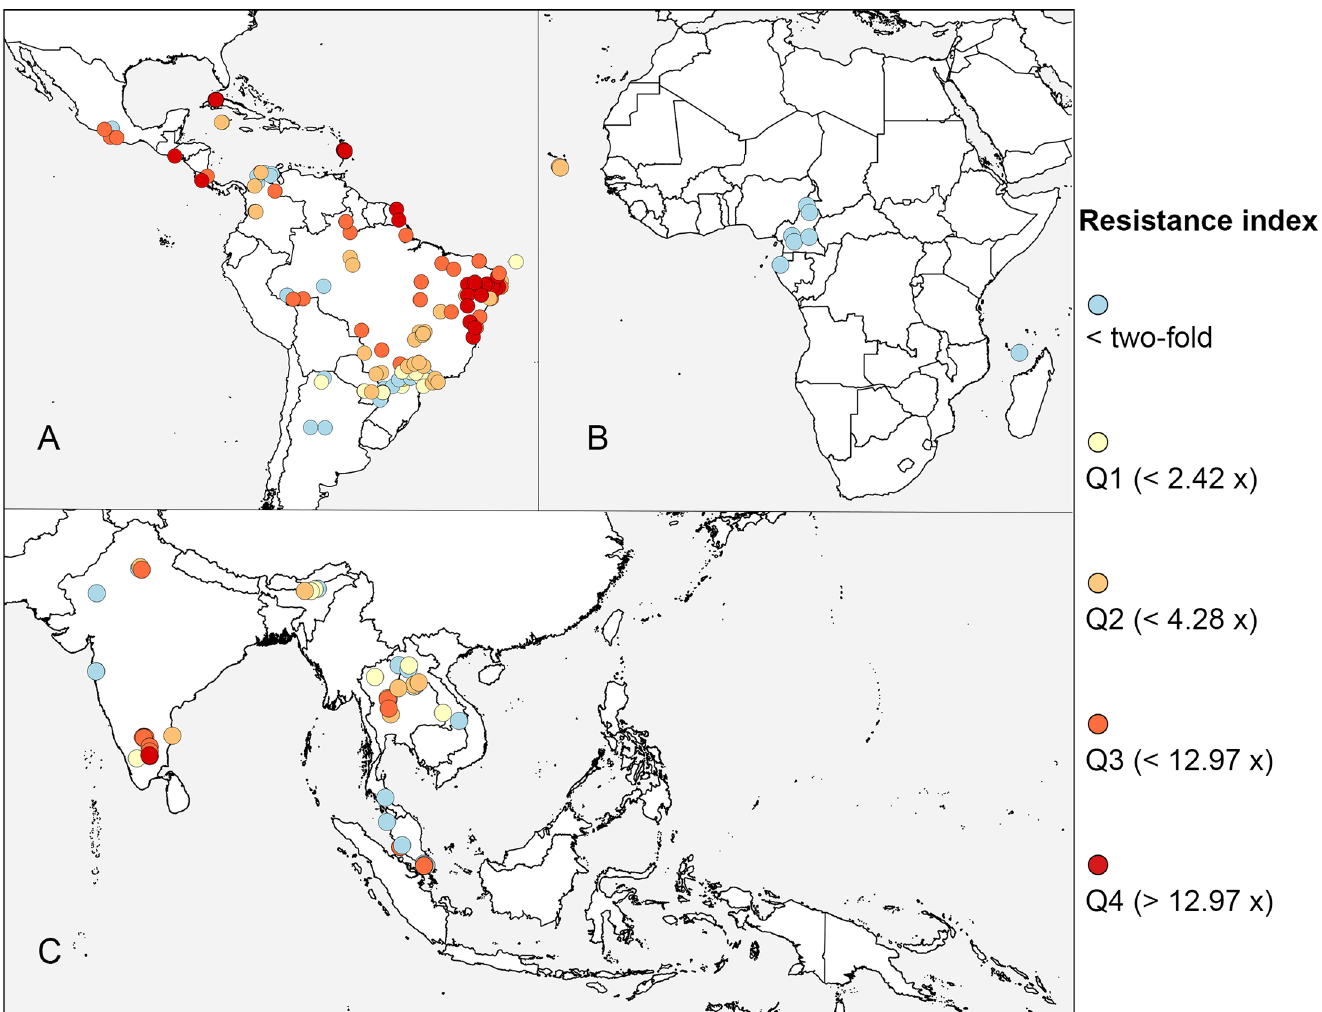
Fig 3. The level of Ae . aegypti resistanceto temephos, 2006–2015. The ratio of the lethal concentration requiredto kill half of the sample (LC 50 value) obtained by each study to the value obtained for the Rockefellersusceptiblestrain across studies was calculated. The ratios were then split into 5 classes: values less than 2-fold higherthan Rockefeller and each quartileof the remaining distribution.The map is zoomed to the 3 regions with data. (A) Americas. (B) Africa. (C)